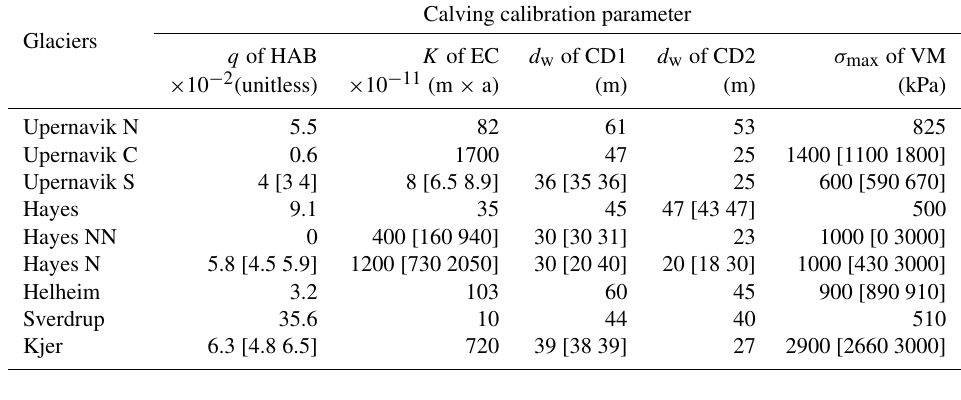
Table 1. Chosen calibration parameters. The values in brackets are the range of calibration parameters that produce a qualitatively similar ice front retreat pattern to the chosen calibration parameter.